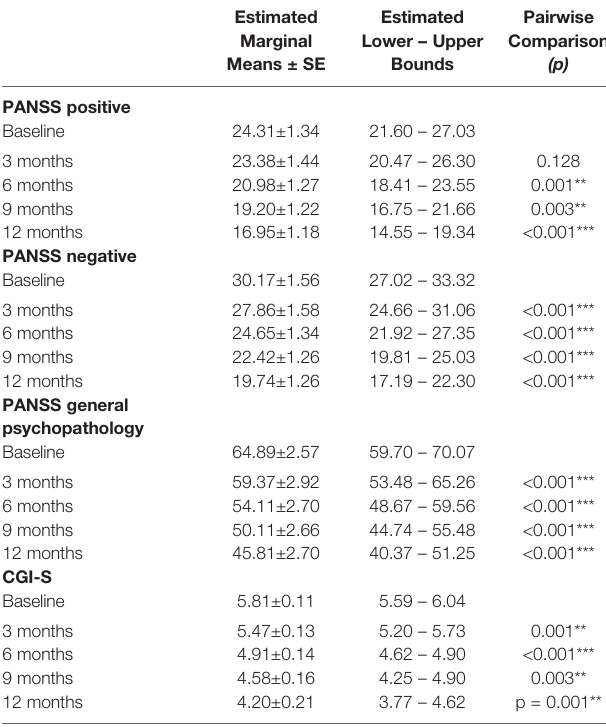
TABLE 1 | PANSS and CGI-S, within-subjects pairwise comparisons; signi fi cance between successive time-points; * p < 0.05; ** p < 0.01; *** p <